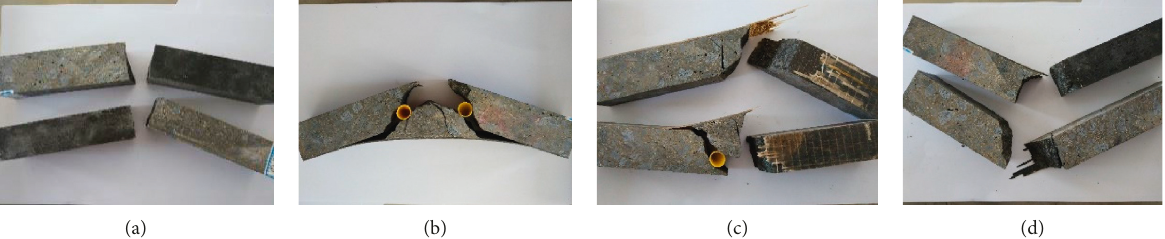
Figure 17: Fracturing behaviors of the beam specimens of resin composite overlays reinforced with different fibers at − 10 ° C. (a) Blank. (b) CF. (c) GF. (d)